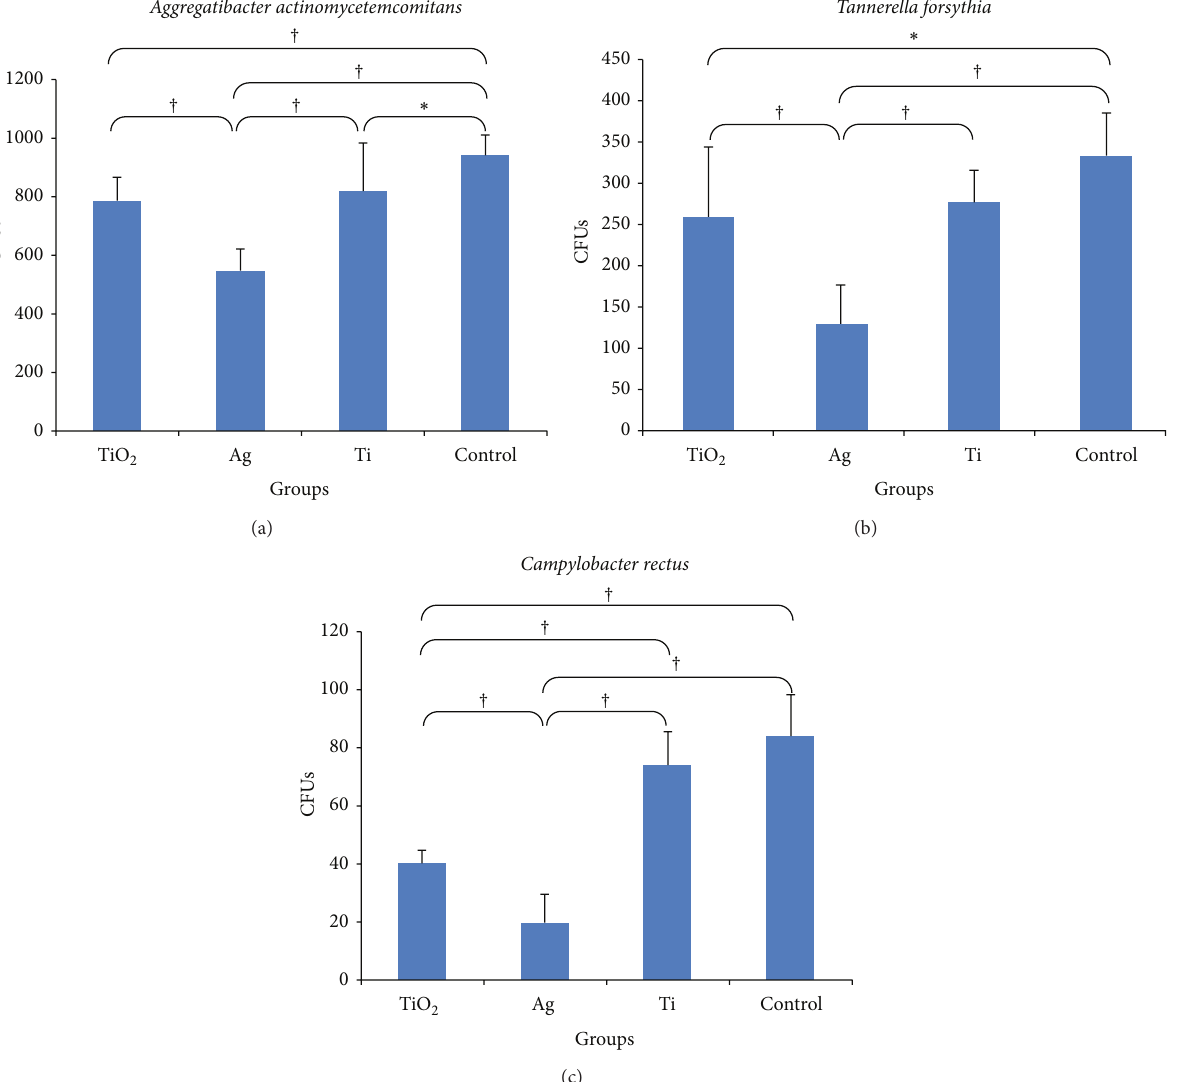
Figure 3: Descriptive analysis of adhesion of (a) A. actinomycetemcomitans , (b) T. forsythia , and (c) C. rectus on all groups tested (Group TiO 2 : as-annealed TiO 2 nanotubes; Group Ag: as-annealed Ag doped TiO 2 nanotubes; Group Ti: commercially pure Ti sheet; Control Group: 24- well cell culture plate bottoms). Data are presented as the mean ± SD (standard deviation). Results were analyzed using a one-way ANOVA and post hoc analyses were performed using Tukey’s studentized range (HSD) test ( ∗ 𝑃 < 0.05 and † 𝑃 < 0.01